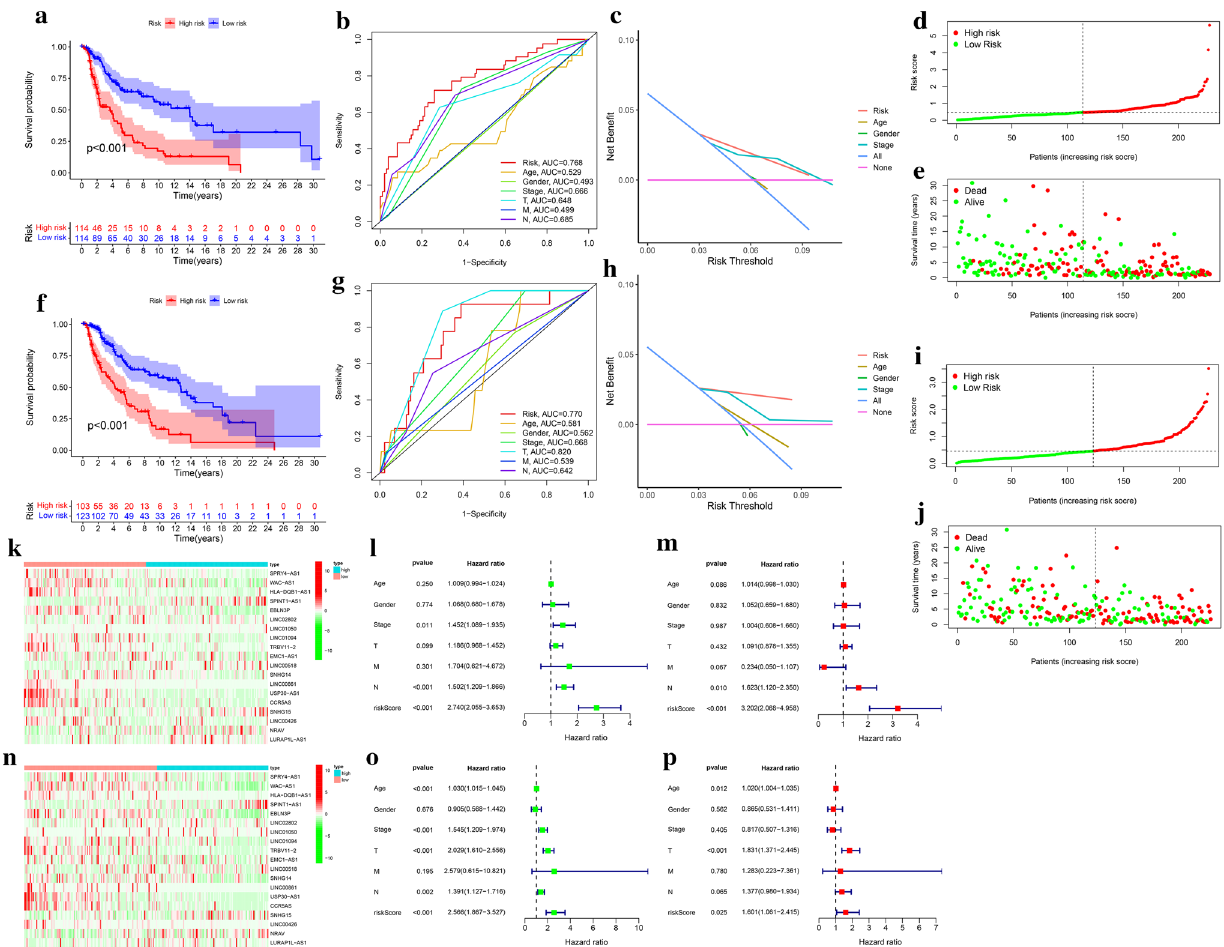
Fig. 4 Assessment of the prognostic prediction ability of the FRLs signature. a , f The Kaplan–Meier survival analysis for high- and low-risk groups in training and testing groups. b , g The ROC curve was used to evaluate the predictive efficiency of the prognostic signature. c , h The DCA curve demonstrated that the risk score performed better than traditional clinicopathological factors in predicting the prognosis of SKCM. d , e , i , j The distribution plots of the risk score and survival status in the training and testing groups. k , n The heat map of FRLs for the low-and high-risk groups in the training and testing groups. l , o The univariate Cox regression of prognostic factors in the training and test- ing groups. m , p The multivariate Cox regression of prognostic factors in the training and testing